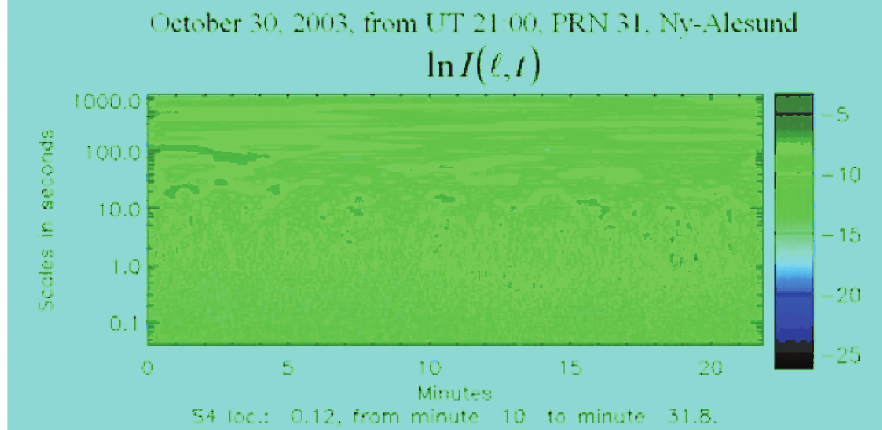
Fig. 13. An example of scalogram from CWA for amplitude scintillation signals.